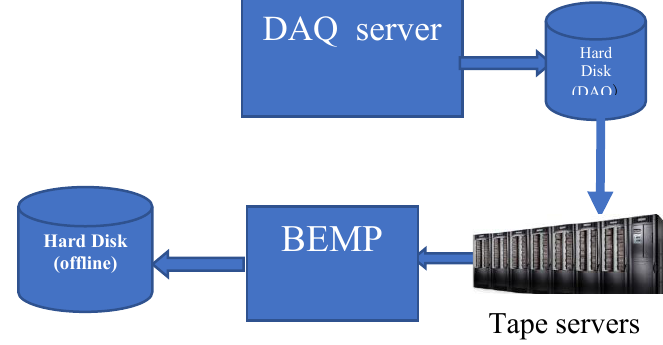
Fig. 2. The processing flow of raw